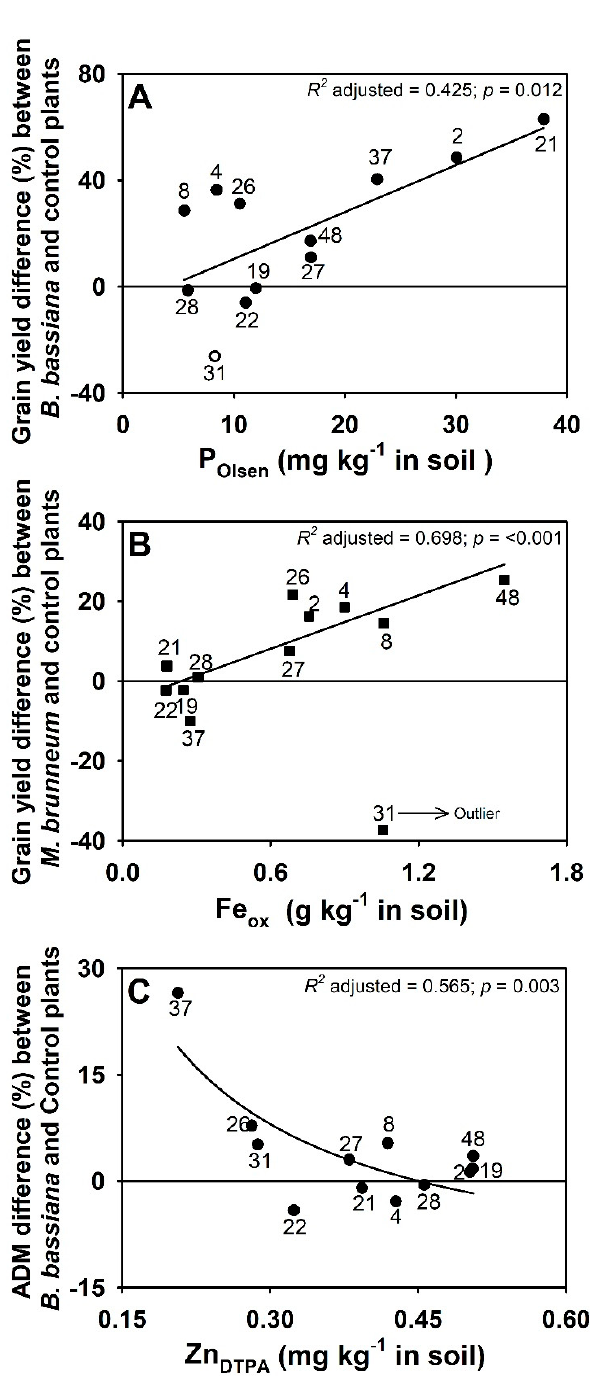
Figure 4. Regression models for the difference in grain yield between the Control plants and those inoculated with B. bassiana or M. brunneum as a function of the initial soil available P (P Olsen , A ) and Fe in poorly crystalline Fe oxides (Fe ox , B ), respectively; and differences in aerial dry matter (ADM) between the Control plants and those inoculated with B. bassiana as a function of soil available Zn (Zn DTPA , C ) at harvest. The numbers by the symbols are soil codes.